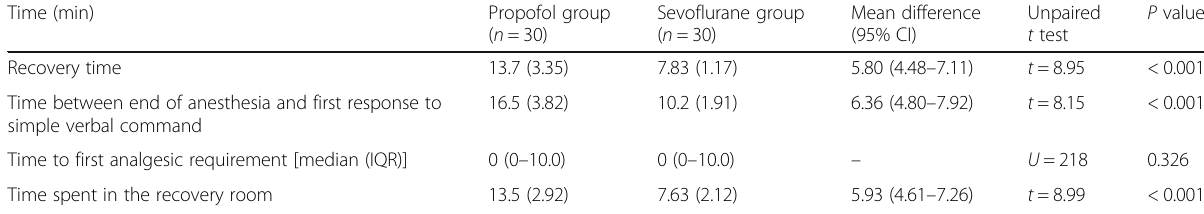
Data are represented as mean±SD Equality of variance was violated